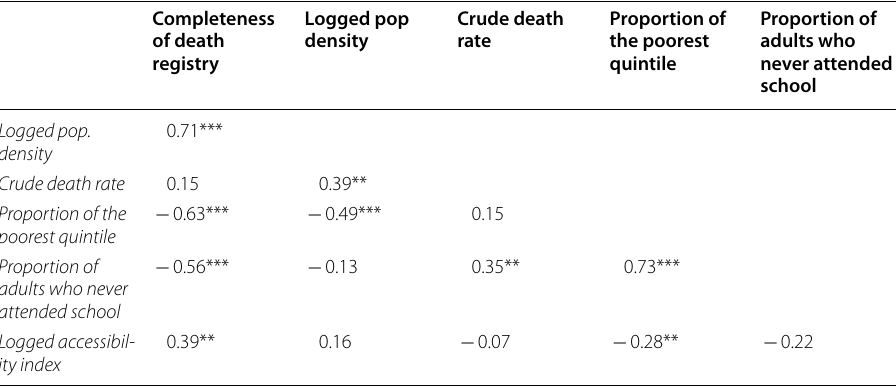
Table 2 Correlation matrix of completeness of death registration, logged population density, crude death rate, logged index of accessibility of registration